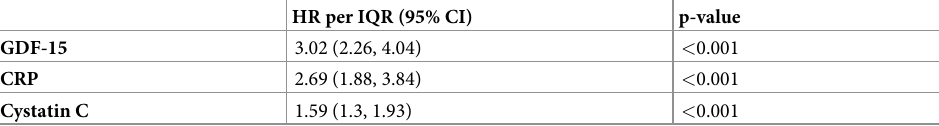
Table 4. Longitudinal biomarker measurements: Hazard ratios for death from CHD estimated by joint models.